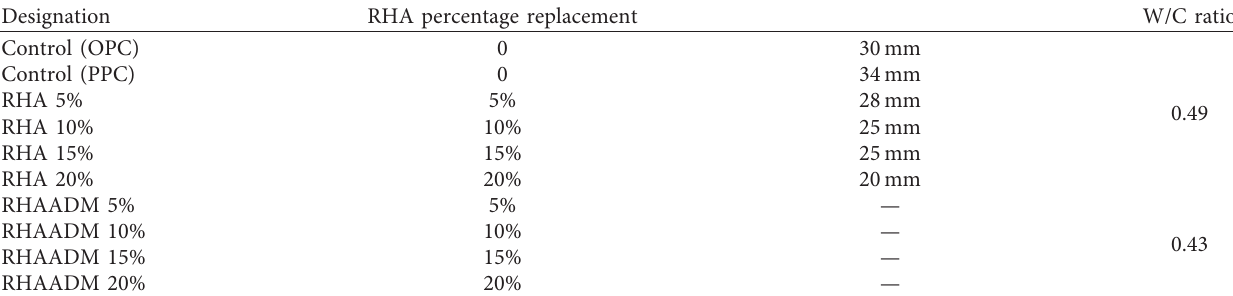
Table 4: Workability test results of freshly mixed concrete mixtures.